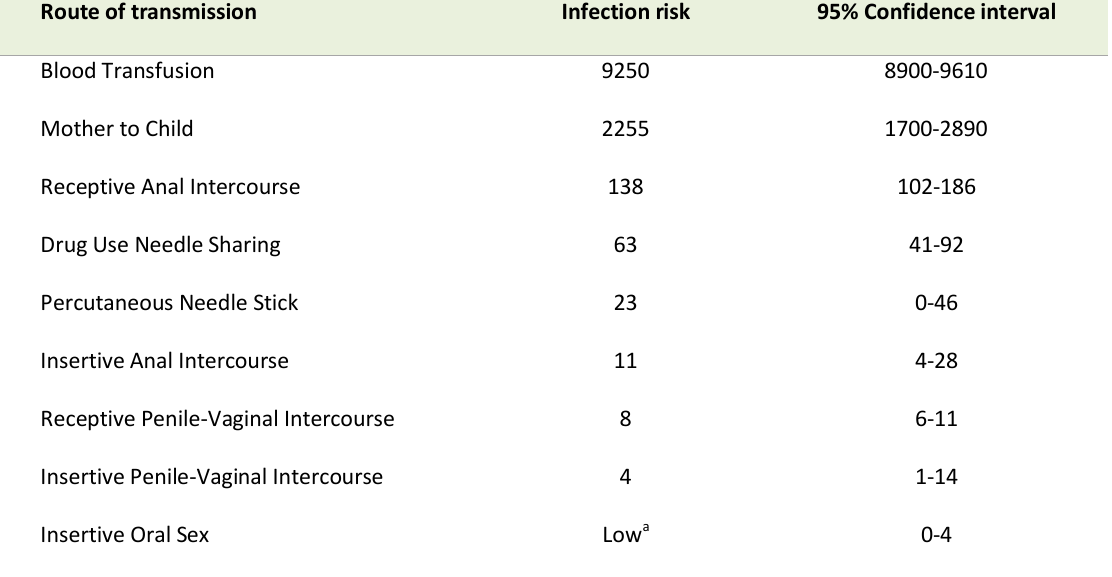
Table 1. Estimated per-act HIV transmission risk per 10,000 exposures. Adapted from